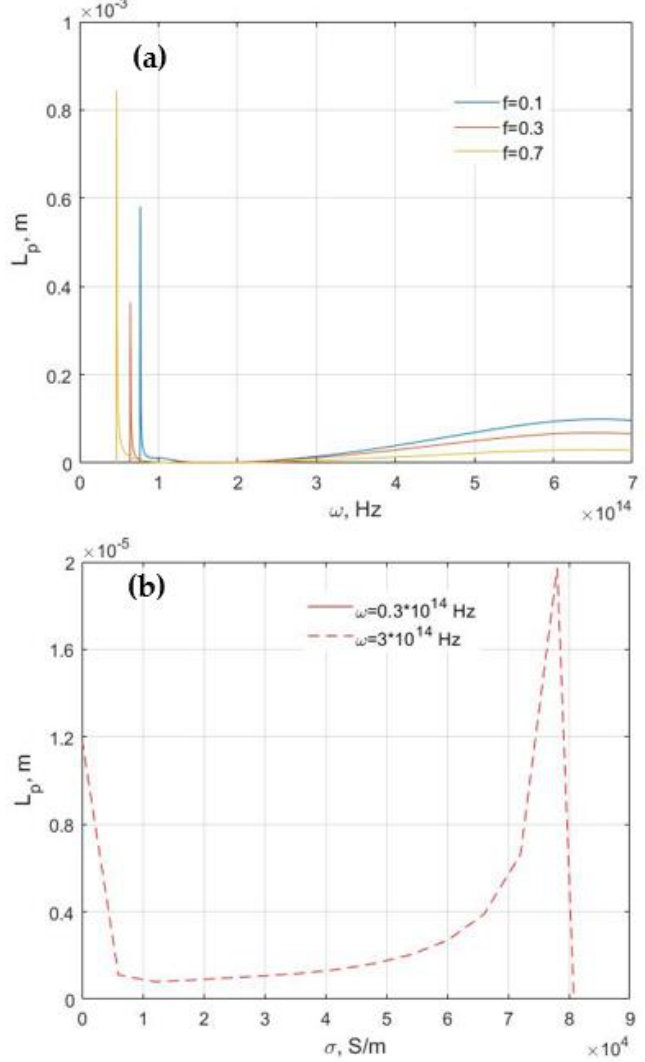
Figure 10. Dependence of propagation length versus frequency for different filling factors ( a ) and versus conductivity for f = 0.3 ( b ). ε n = 11.8, ε d = 2.25. All the presented results are obtained for the ITO inclusions.